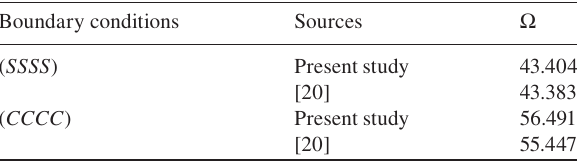
Table 2 Convergence study of laminated square plates with intermediate line supports in each direction for different boundary